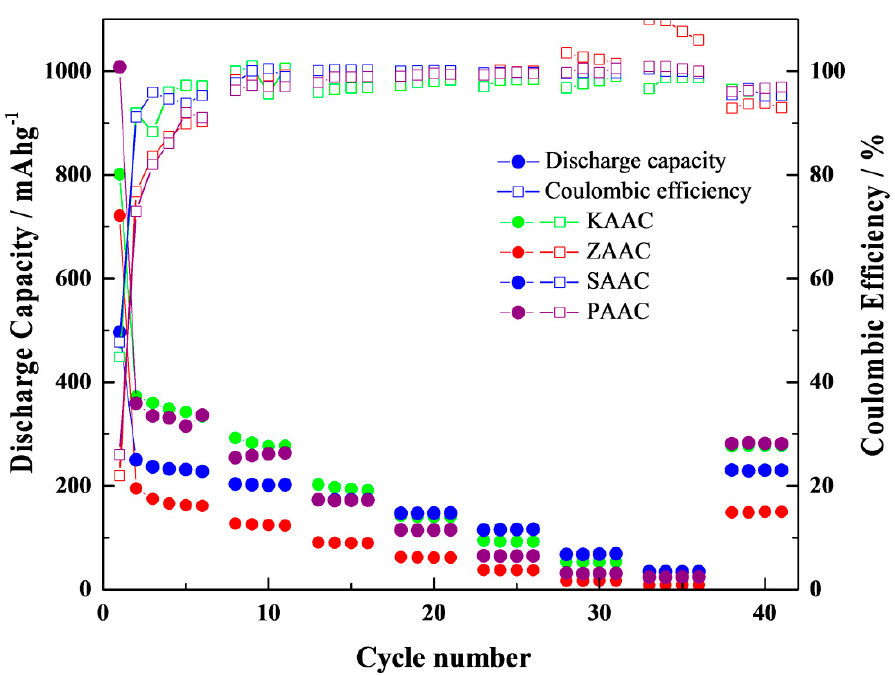
Figure 6. Rate capability of AC electrodes with ZnCl 2 , H 2 SO 4 , KOH, and H 3 PO 4 activators from 0.1 to 10 C.